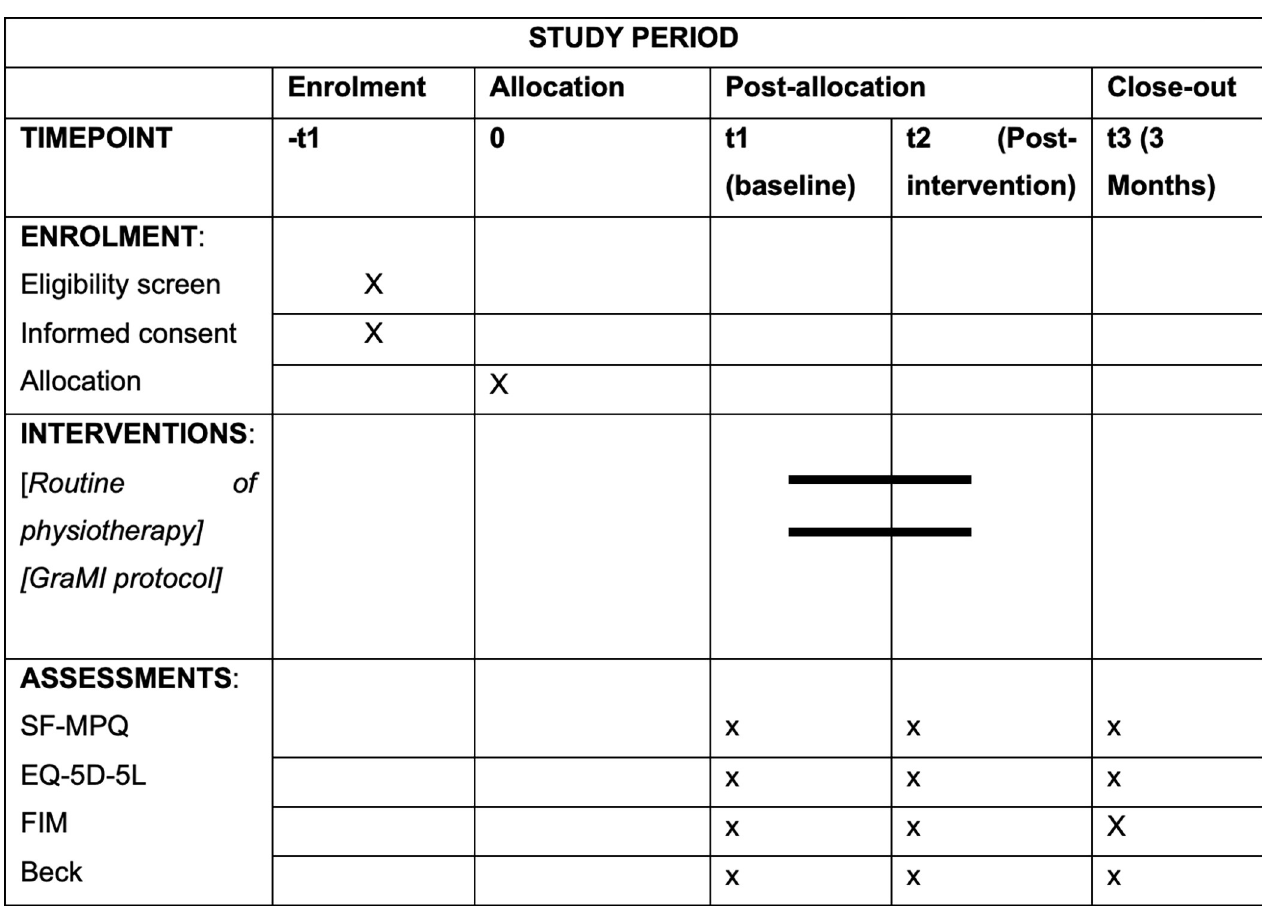
Fig 1. Outlines when each study component occurs in accordance with the SPIRIT guidelines. SF-MPQ: Short form McGill Pain Questionnaire, EQ-5D-5L: EuroQool-5D-5l, FIM: Functional Independence Measure, Beck: Inventario de depresio´n de Beck, t: Timepoint, GraMI: Graded motor imagery.